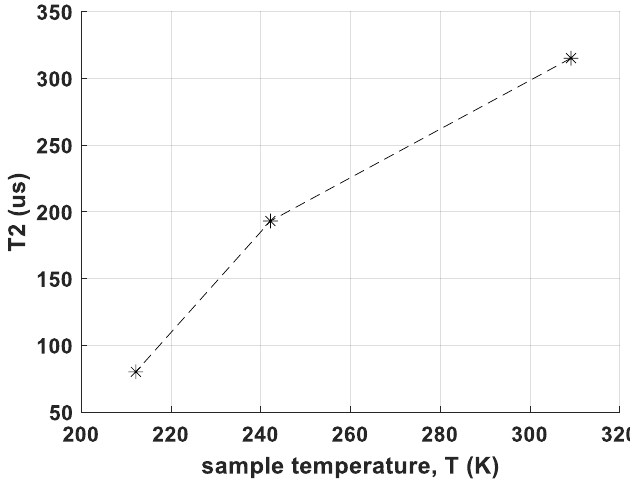
Figure 3. Temperature dependence of the spin-spin relaxation time constant T 2 for transition 7/2 → 5/2 of sample CS, site A. The dashed line serves as a guide to the eye.